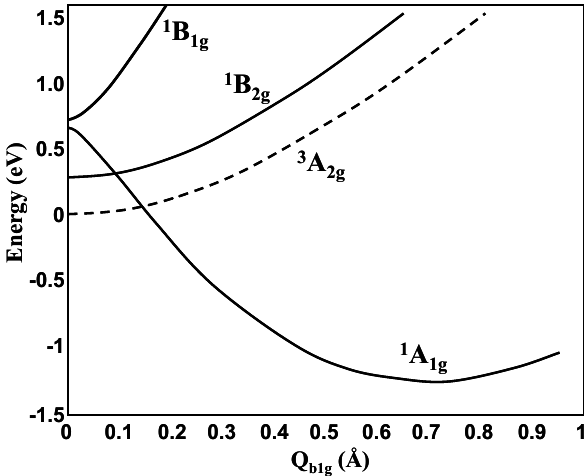
Figure 5. Cross section of the APES along the θ Q coordinate for the terms arising from the electronic e 2 configuration of Si 3 [6]. Its main features are similar to those for CuF 3 (Figure 5), but with different parameter values (for ∆ and ∆ 0 see Figure 1 and Equation (1)).